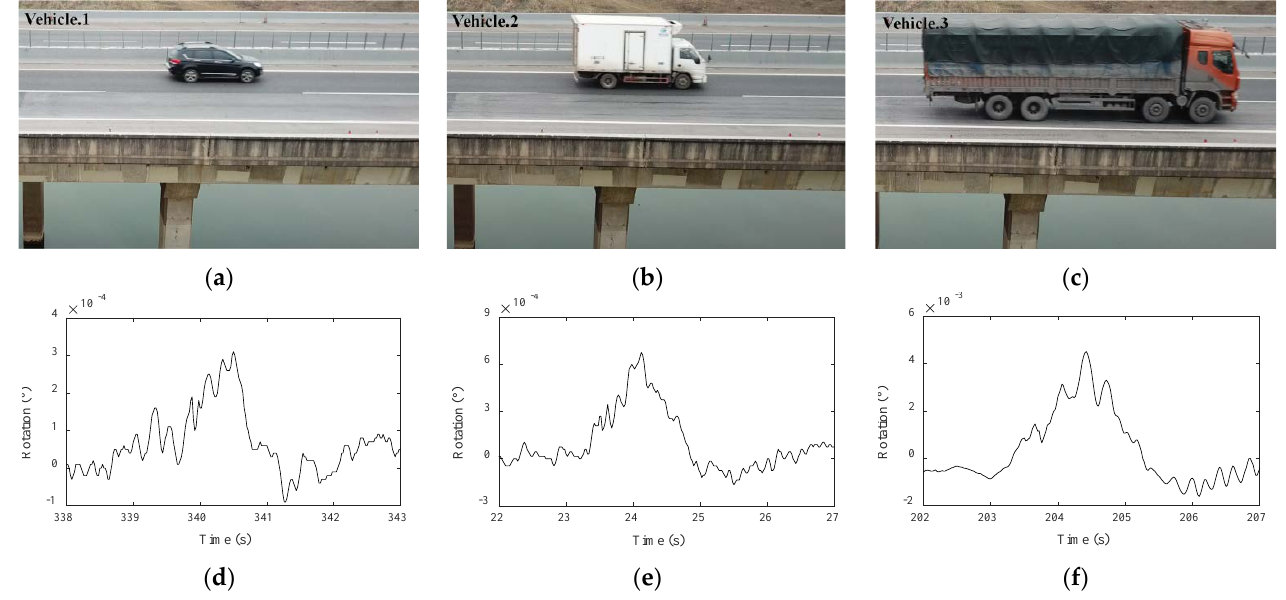
Figure 15. Beam-end rotation monitoring data under different vehicle loads ( a ) small vehicle; ( b ) medium vehicle; ( c ) large vehicle; rotation response to ( d ) small vehicle; ( e ) medium vehicle; ( f ) large vehicle. Table 3. Rotation responses generated by different types of vehicles.